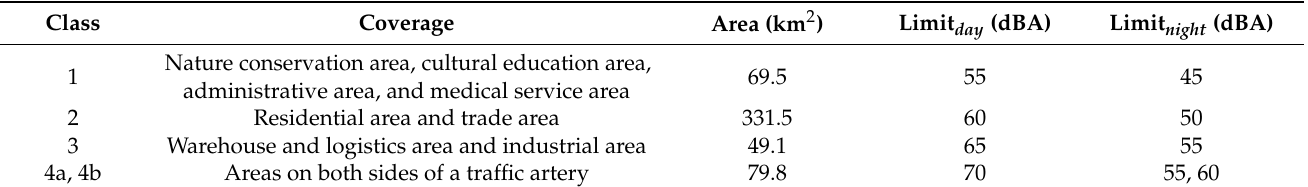
Figure A3. Day – night urban traffic noise map of Panyu District, Guangzhou City [36]. Table A1. Area, coverage, and noise limits of acoustic environment functional areas in Panyu District of Guangzhou City [50].